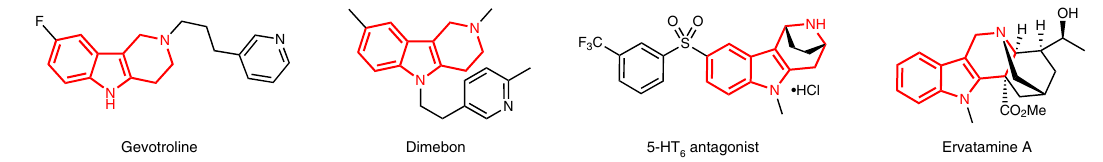
Fig. 1 Representative examples of bioactive compounds. Tetrahydro- γ -carboline scaffolds are structural cores in many natural products and pharmaceuticals.